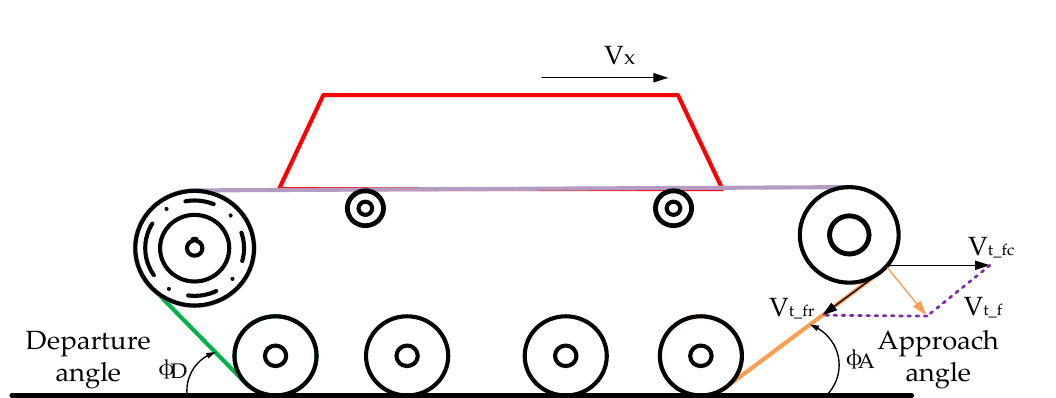
Figure A1. Schematic diagram of the velocity resolution of a DDTV.